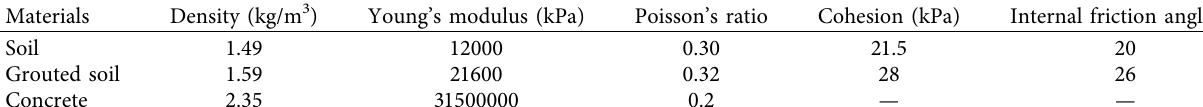
Table 2: Basic physical and mechanical parameters of the materials.